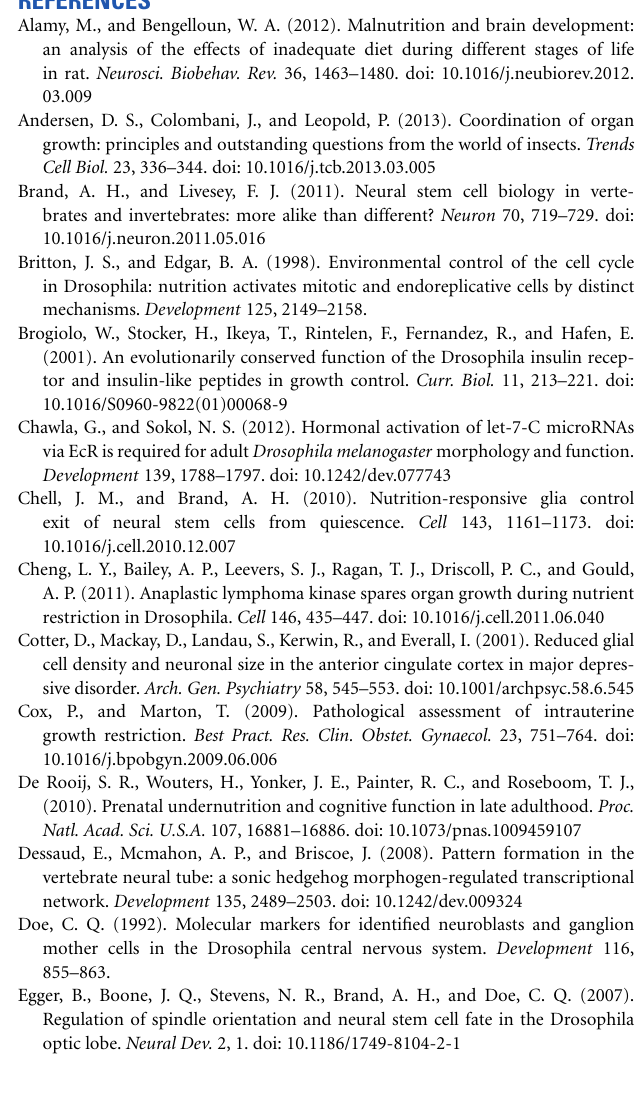
FIGURE 4 | Continued body neuroblasts first generate neurons of the γ fate. Once critical weight is attained, production of ecdysone triggers the expression of micro-RNAs of the Let-7-Complex ( Let-7-C )thattargetchinmomRNA,leadingtodecreasinglevels of Chinmo in newly-born neurons. Progressive downregulation of Chinmo over time forces successively born neurons to adopt the α (cid:3) β (cid:3) and finally αβ fate. In a low protein/high sugar diet, the critical weight is delayed, and more neurons of the γ -class are generated (Lin et al., 2013). On the right, schemes represents adult brains with the different classes of mushroom body neurons depicted in various colors. The γ class extends in the high sugar/low protein diet. (B) In the optic lobe, neuroepithelium (NE) expansion (proliferative phase) is highly